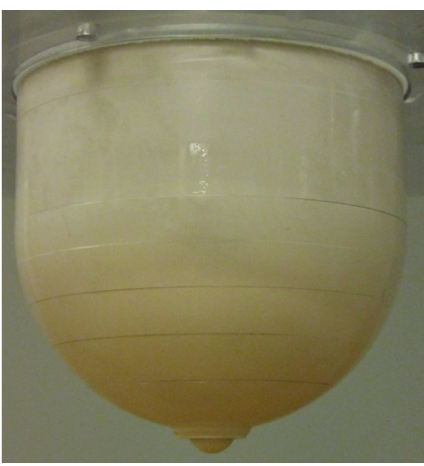
Figure 7: Dielectric breast phantom.